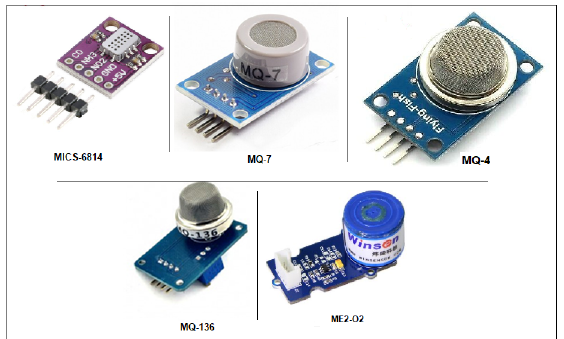
Fig. 4 Sensors used in the